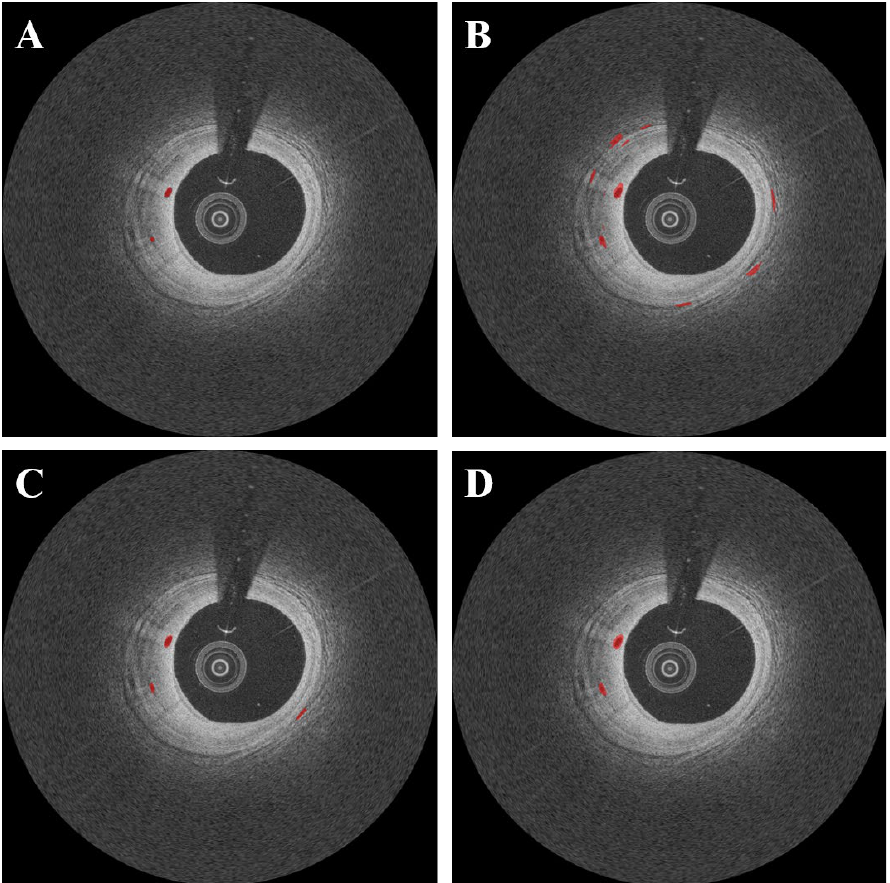
Figure 7. Segmentation results of microvessel according to different semantic segmentation models. Panels are as follows: ( A ) manual annotation, ( B ) results obtained using U-Net, ( C ) results obtained using SegNet, and ( D ) results obtained using DeepLab v3 plus. In ( C ), the SegNet had similar results as compared with DeepLab v3 plus; however, there were some misdetections. The U-Net ( B ) had the worst detection results among all deep learning models. The red is a